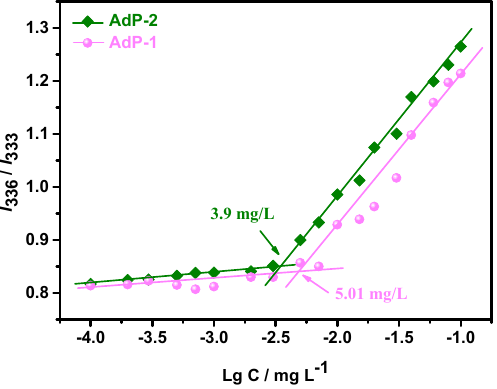
Figure 1. Proton nuclear magnetic resonance ( 1 H NMR) spectra of Ad-P[(EMA- co - t BMA)] 4 in CDCl 3 - d ( a ); Ad-P[(EMA- co - t BMA)- b -PPEGMA] 4 in CDCl 3 - d ( b ); Ad-P[(EMA- co -MAA)- b -PPEGMA] 4 in DMSO- d 6 ( c ).